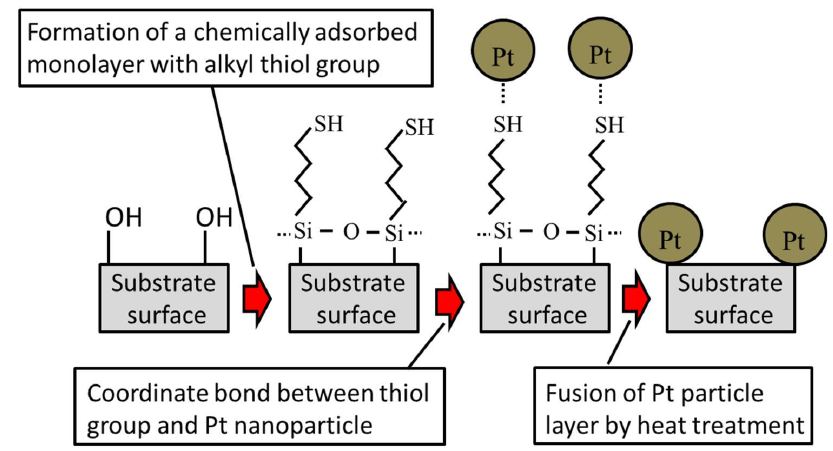
Figure 9. Schematic of the Pt catalyst preparation process.